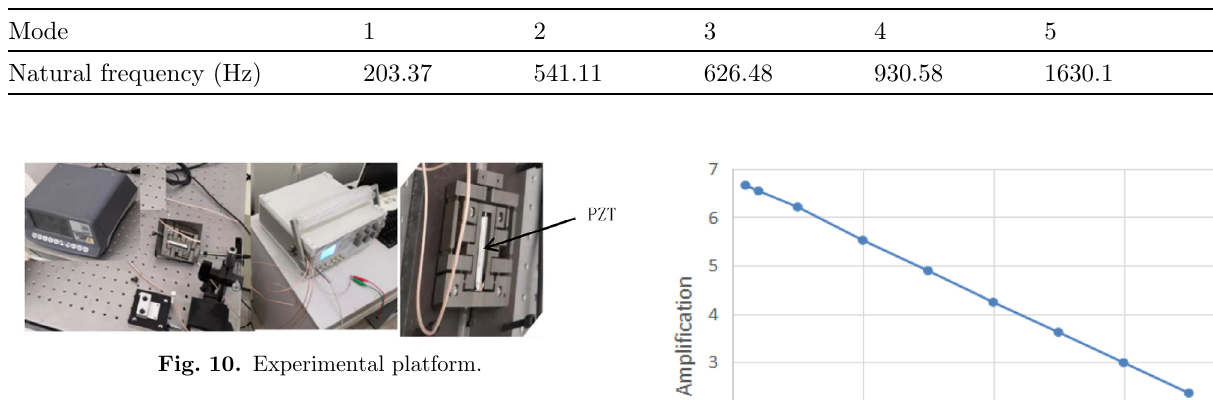
Table 3. Natural frequency simulation results.